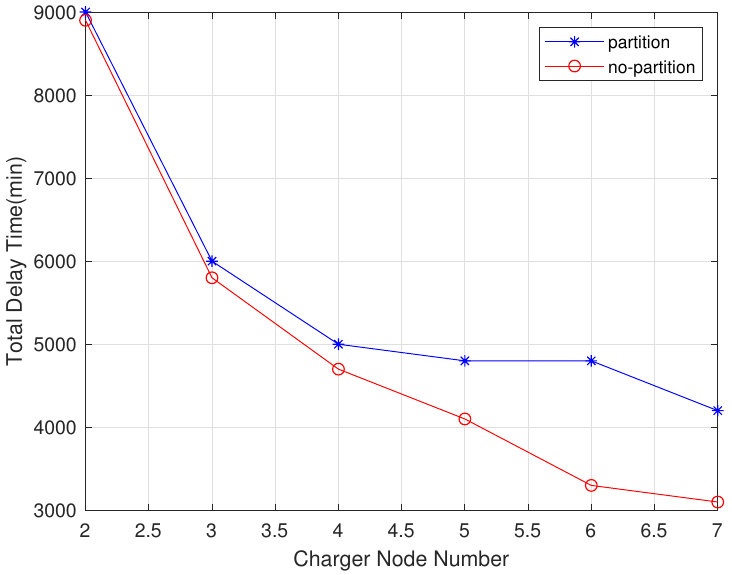
Figure 19. Total delay time varies with charger